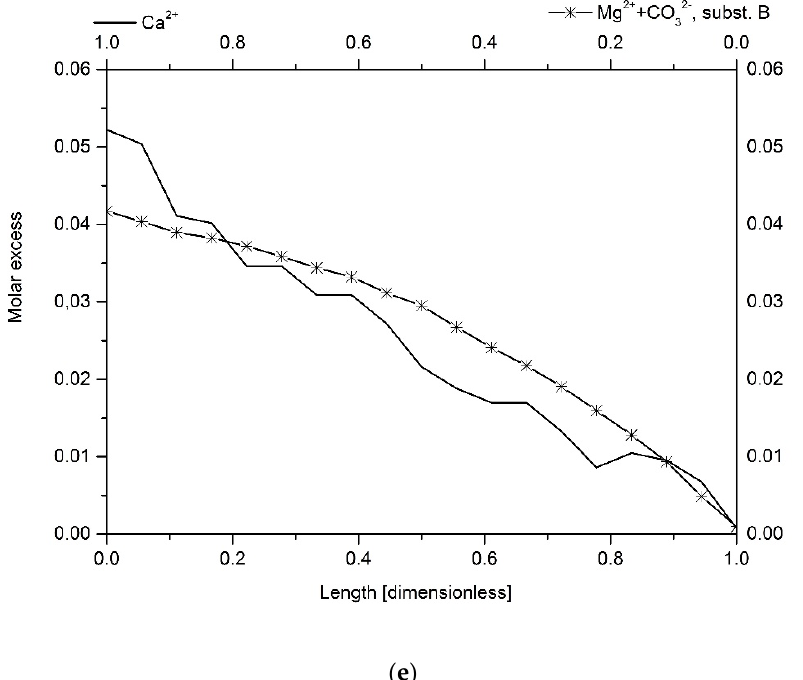
Figure 5. ( a ) Profile of supposed excessive CO 32 − distribution in substitution B along the enamel length compared with the summary profiles of ions Na and K, compensating the charge change; ( b ) profile of Mg distribution along the enamel length compared with sum of F and Cl concentrations. See the reversal of right y axes on ( a , b ), expressing the different directions of chemical reacTable 1. in ( a ), while 1:2 in ( b , c ) the same, but with correction involving the participation of CO 32 − , substitution A; ( d ) comparison of Mg and CO 32 − , subst. B ions, participating in different mechanisms, expressed by Equations (4) and (3), respectively; see the molar ratio 1:3; ( e ) balancing of real Ca loss against the profiles of 2 ions responsible for leaching Ca: Mg (Equation (4)) and CO 32 − , subst. B (Equation (3)).